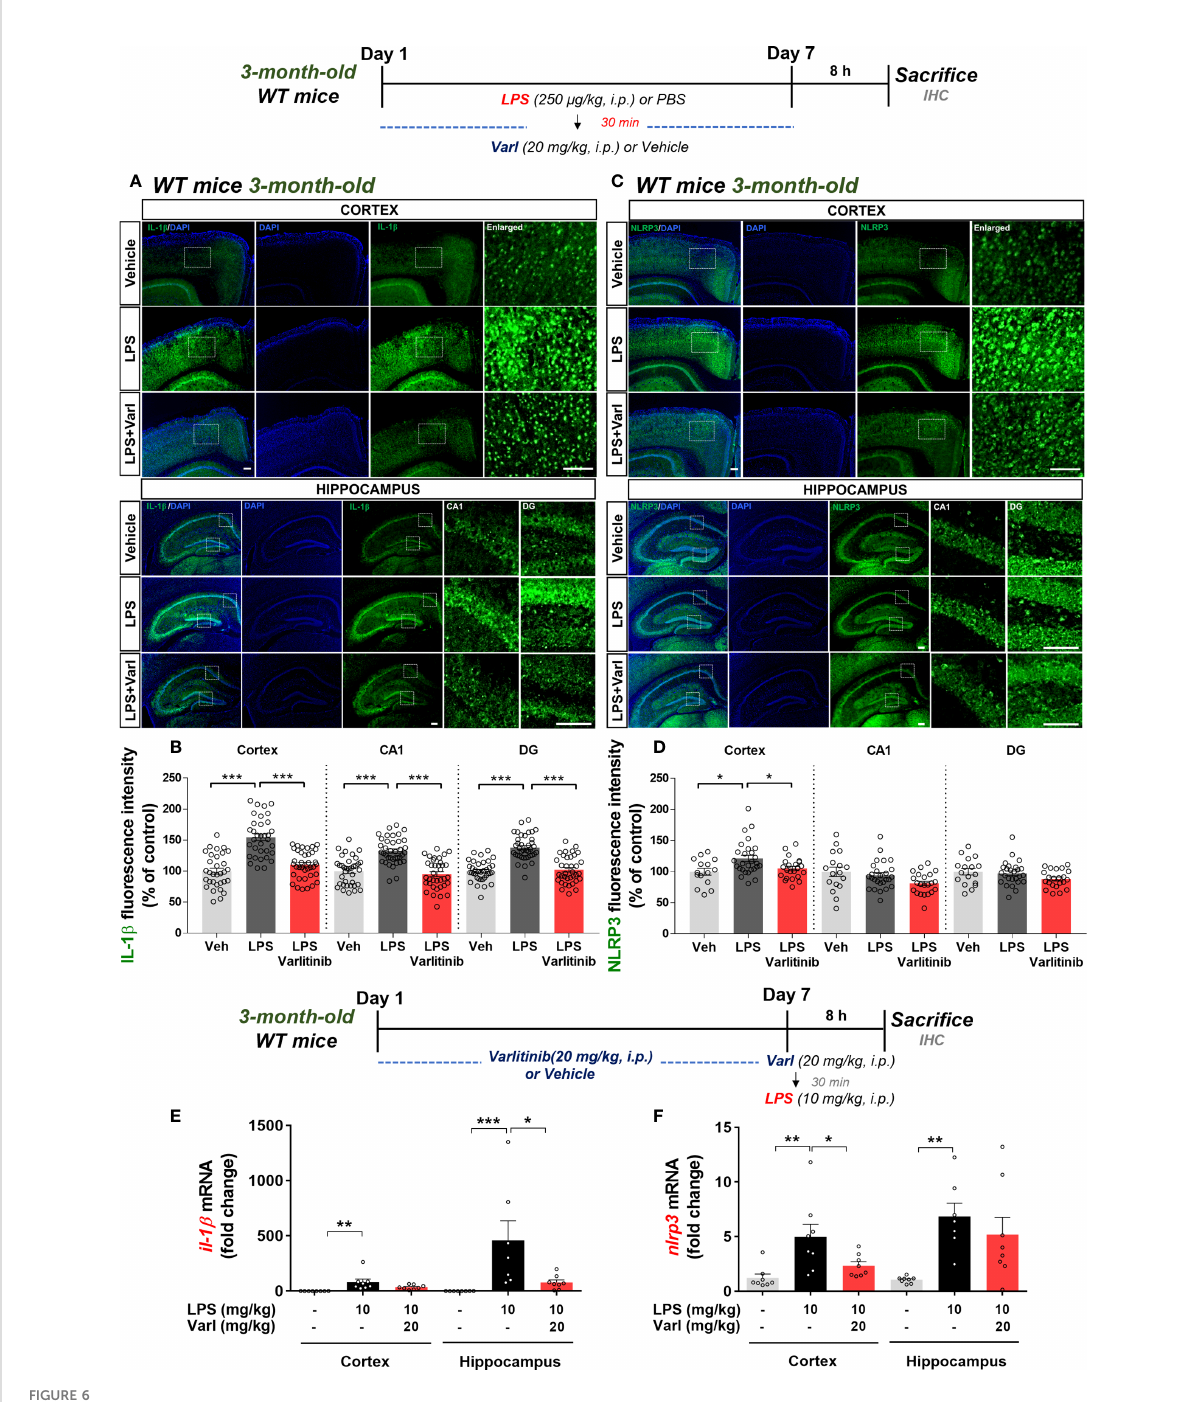
FIGURE 6 Varlitinib downregulates proin fl ammatory cytokine IL-1 b levels and NLRP3 in LPS-treated C57BL/6 mice. (A, C) Wild-type mice were injected with LPS (250 m g/kg, i.p.) or PBS and, 30 min later, varlitinib (20 mg/kg, i.p.) or vehicle (5% DMSO, 10% PEG, 20% Tween-80, i.p.) daily for 7 days. On the 7 th day, 8 h after the LPS or PBS injection, immuno fl uorescence staining was conducted with anti-IL-1 b and anti-NLRP3 antibodies. (B, D) Quanti fi cation of data from A and C (n = 4 mice/group, Veh: 15 brain sections; LPS: 28 brain sections; LPS+Varlitinib: 22 brain sections, Il-1 b : 2 experimental replicates per group). (E, F) Wild-type mice were injected with varlitinib (20 mg/kg, i.p.) or vehicle (5% DMSO, 10% PEG, 20% Tween-80, i.p.) daily for 7 days. On day 7, the last varlitinib or vehicle injection was followed 30 min later by injection of LPS (10 mg/kg, i.p.) or PBS. Eight hours after the LPS or PBS injection, nlrp3 and il-1 b mRNA levels were measured by real-time PCR ( nlrp3 and il-1 b : cortex: C: n = 8; L: n = 8; L+Varl: n = 8, hippocampus: C: n = 8; L: n = 8; L+Varl: n = 8). * p < 0.05, ** p < 0.01, *** p < 0.001. Veh, Vehicle; Scale bar = 50 m